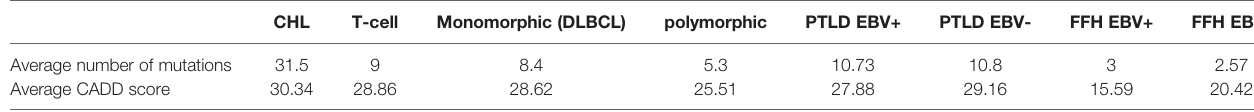
TABLE 3 | Summary of average number of mutations identi fi ed and average CADD score for PTLD subtypes and EBV infection status.